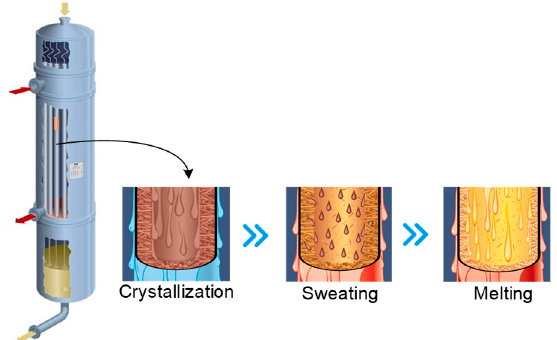
Figure 1. The equipment structure and operating procedures of layer-based crystallization. As layer-based crystallization is a batch operating process, it is less efficient in compar- ison to the suspension crystallization separation method. Figure 2 illustrates the simplified three-stage PX crystallization separation process. The suspension melt crystallization